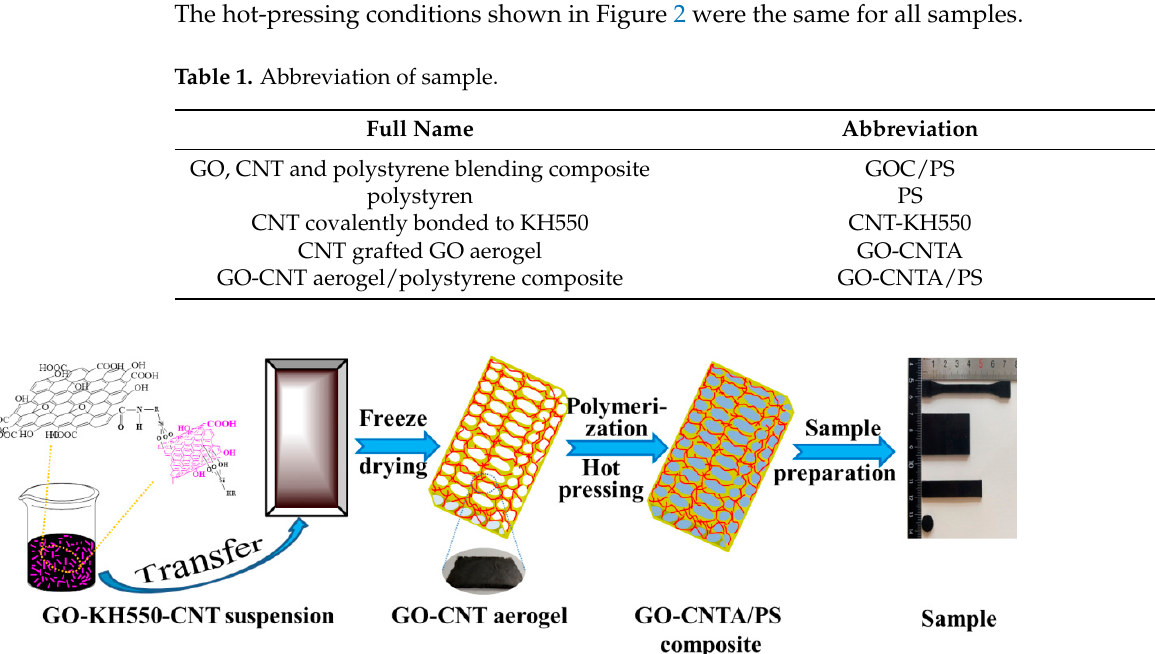
Figure 1. The reaction mechanism diagram.